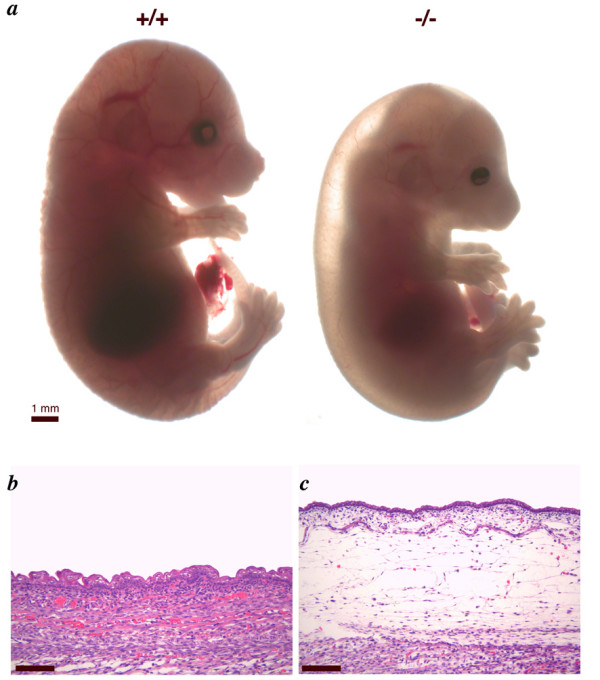
Edema in Ptdsr-/- mice (a) The Ptdsr-/- mutant (15.5 dpc) is growth retarded and the severe edema along the back of the embryo is visible. (b, c) Sagital sections of embryos at 16.5 dpc. The mutant embryo (c) exhibits massive subcutaneous edema compared to a wild-type (b) littermate. Scale bar = 100 μm in (b) and (c).